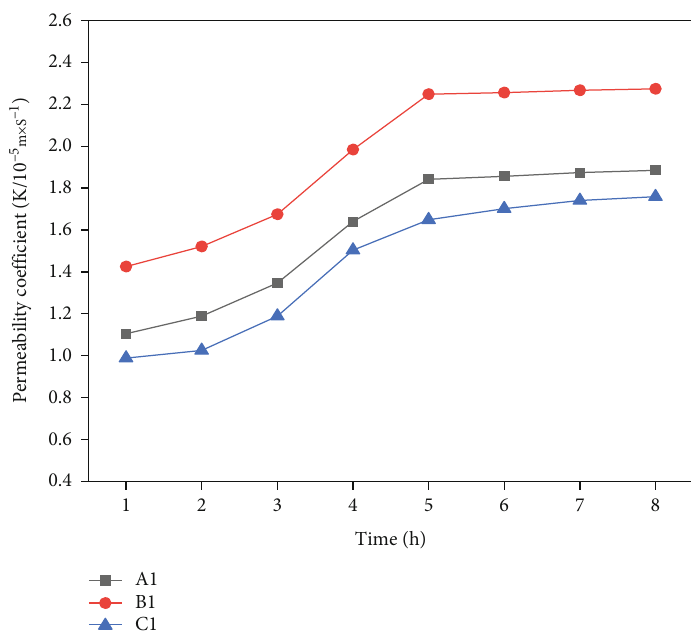
Figure 7: Permeability coe ffi cient of MgSO